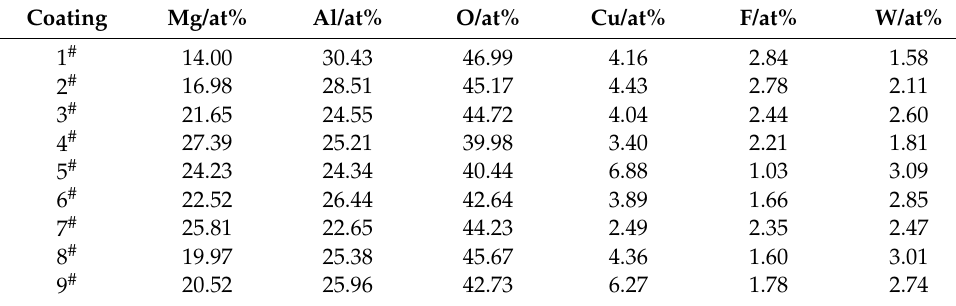
Table 3. EDS results of the coating surface (1 # –9 # ) prepared in different